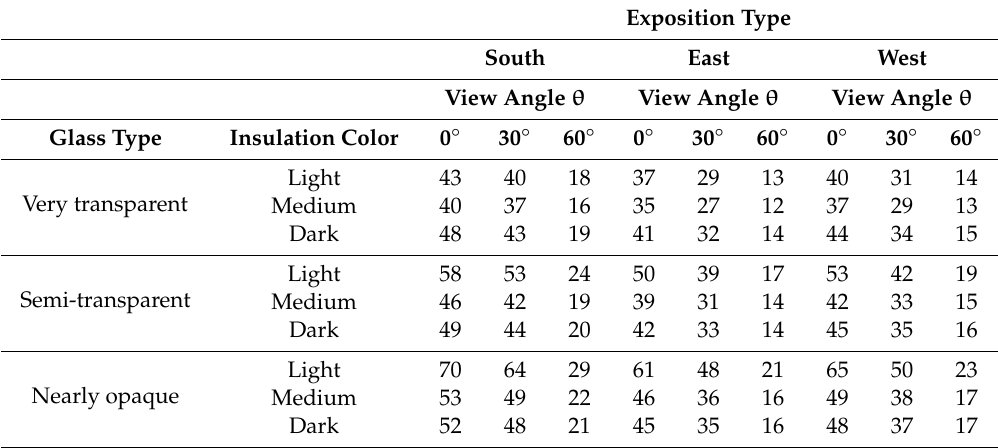
Table 9. Maximum temperature gradients (K) for Mumbai.